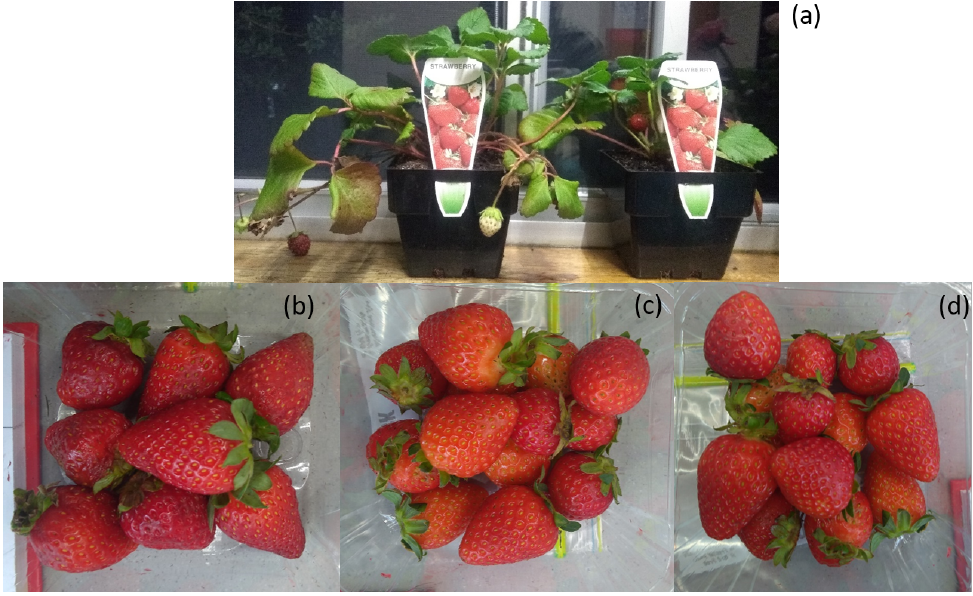
Figure 2. Strawberries used in this research: ( a ) pot grown strawberries; ( b – d ) retail store ac- quired strawberries.